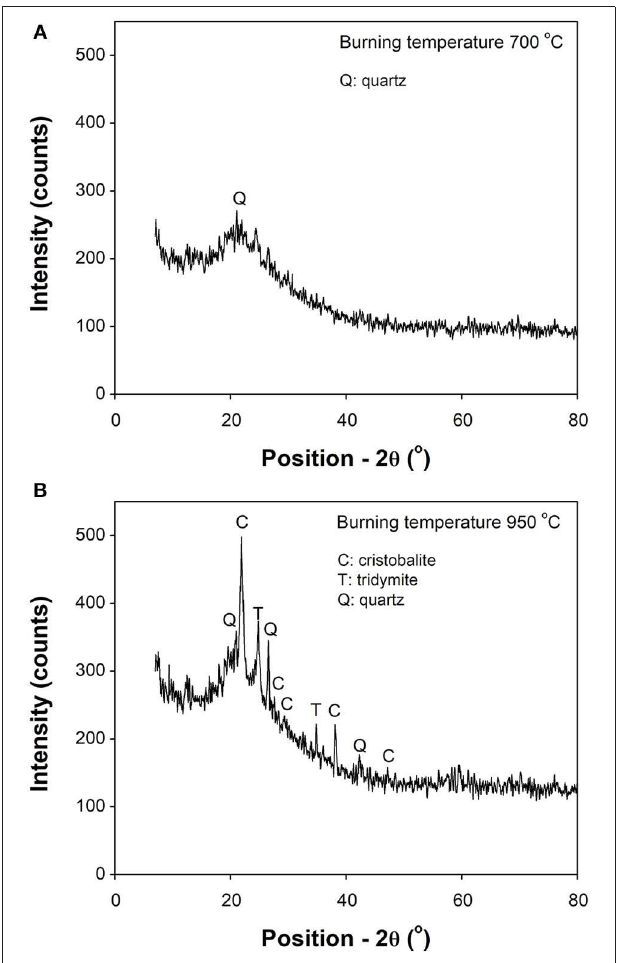
FIGURE 5 | Comparative particle size distribution curves of cement and RHA (passing 75-micron